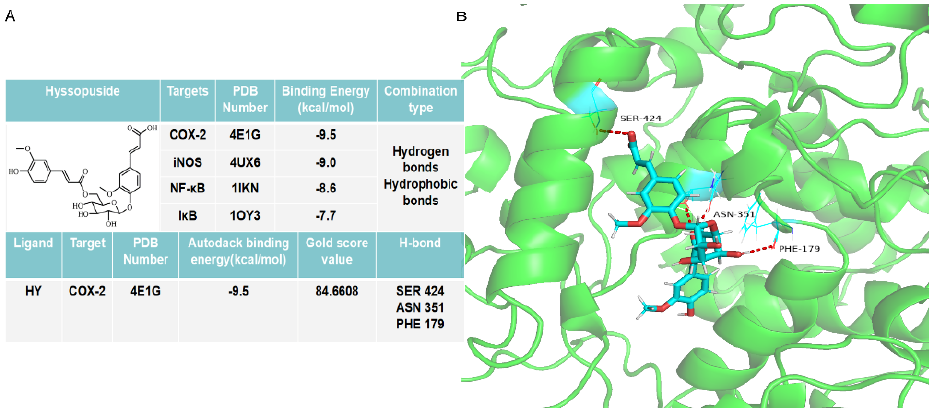
Figure 8. ( A ) The binding energy profile of molecular docking of hyssopuside (HY) with cyclooxygenase-2 (COX-2), inducible nitric oxide synthase (iNOS), nuclear factor kappa-B (NF- κ B), and I κ B (inhibitor of NF- κ B). ( B ) The interaction between HY (in blue) and adjacent amino acid residues (in cyan) in COX-2 domain through hydrogen bonds (red dash).